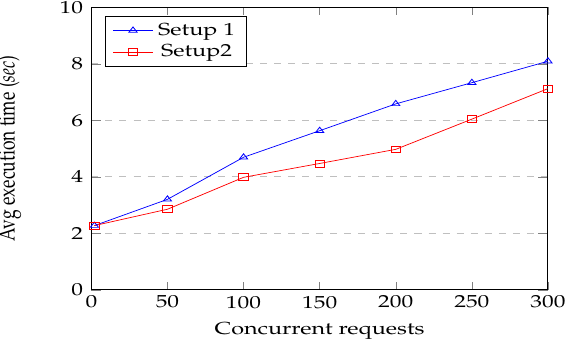
Figure 7. System